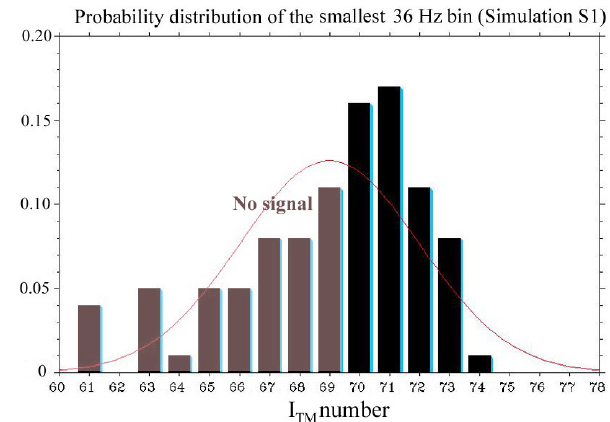
Fig. 7. Distribution of the smallest value of bin 36 derived from simulation S1; the dark-brown bars correspond to the absence of signal (see